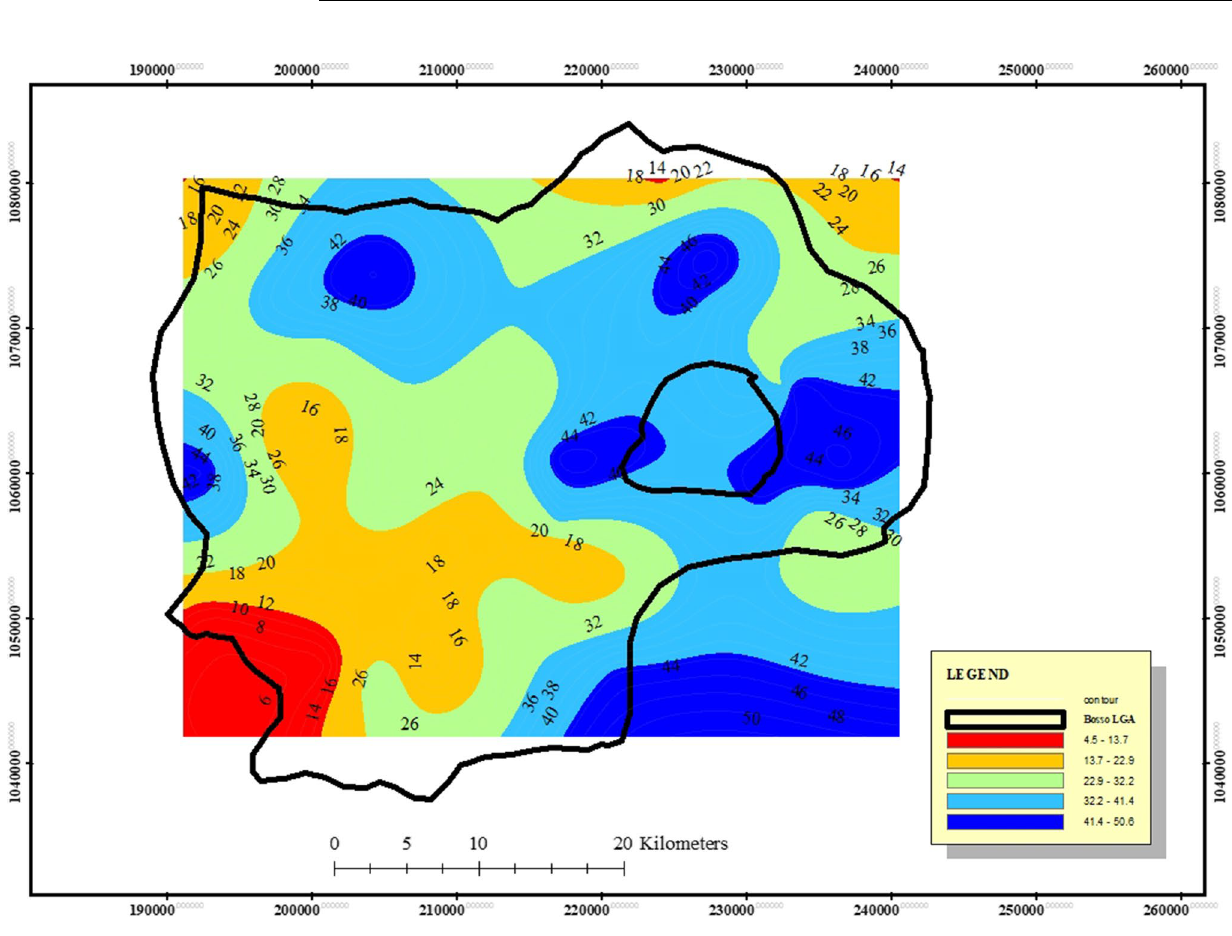
Fig. 11 Depth to basement